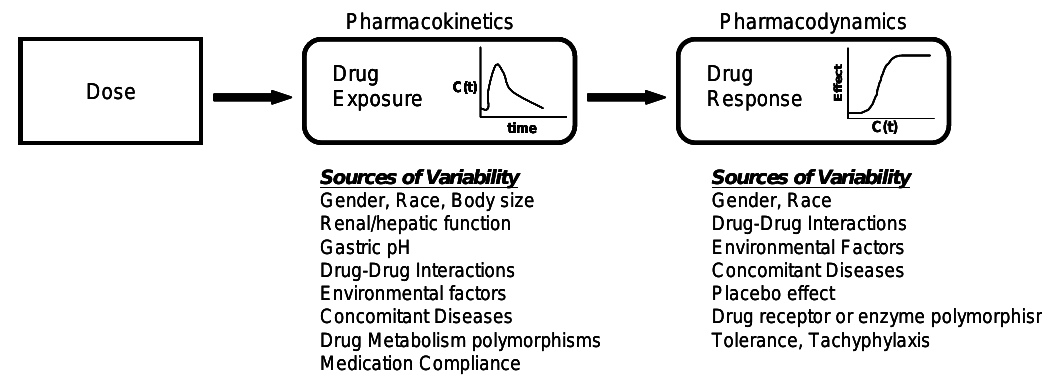
Figure 1. The relationship between dose and clinical effect. Drug exposures, C(t),